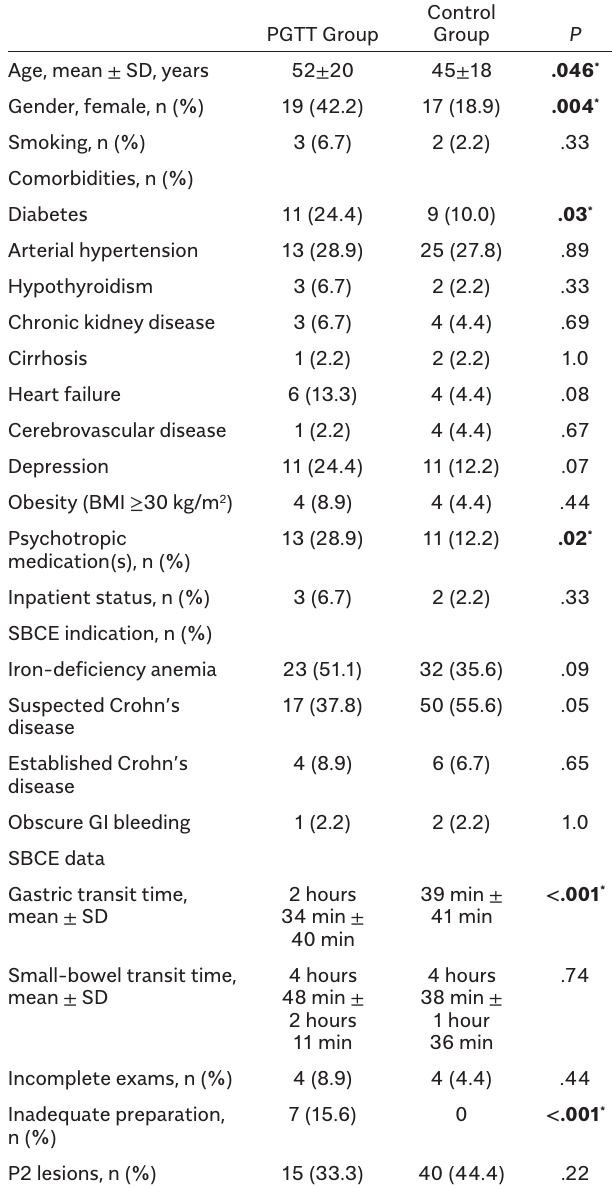
Table 1. Baseline Demographic and Clinical Characteristics of Patients with PGTT on SBCE Examination Age, mean ± SD, years 52 ± 20